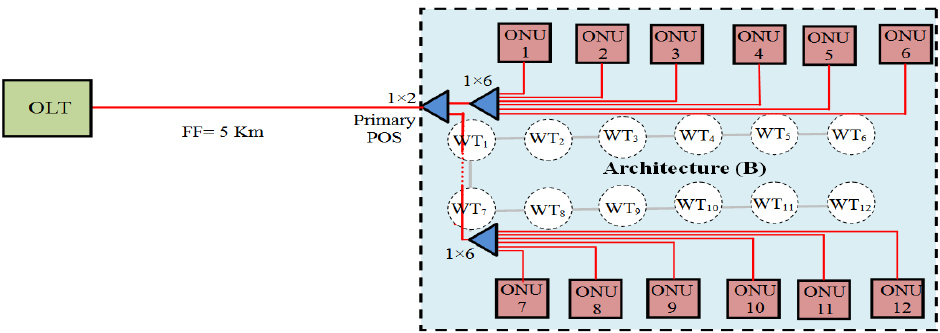
Figure 4. EPON ‐ based architecture (B).